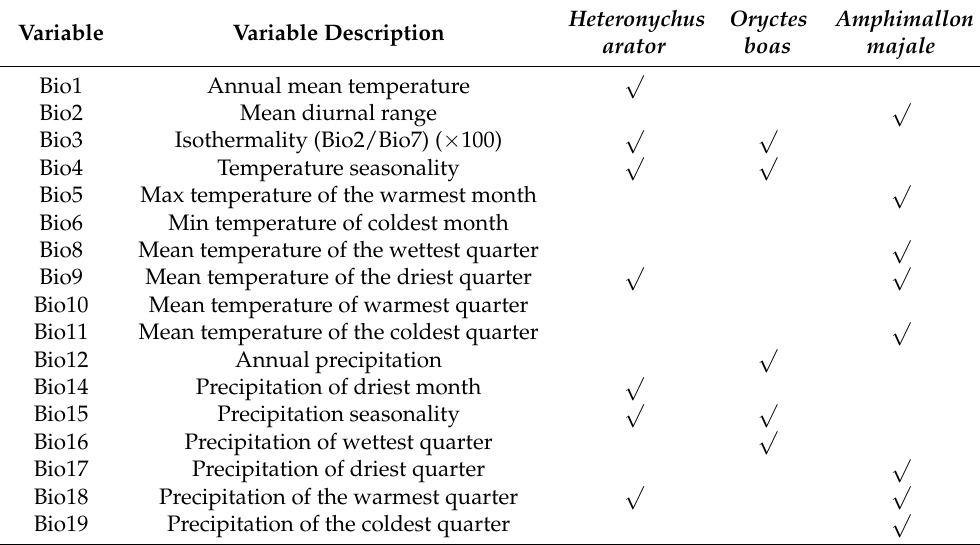
Heteronychus Oryctes Amphimallon arator boas majale √ √ √ √ √ √ √ √ √ √ √ √ √ √ √ √ √ √